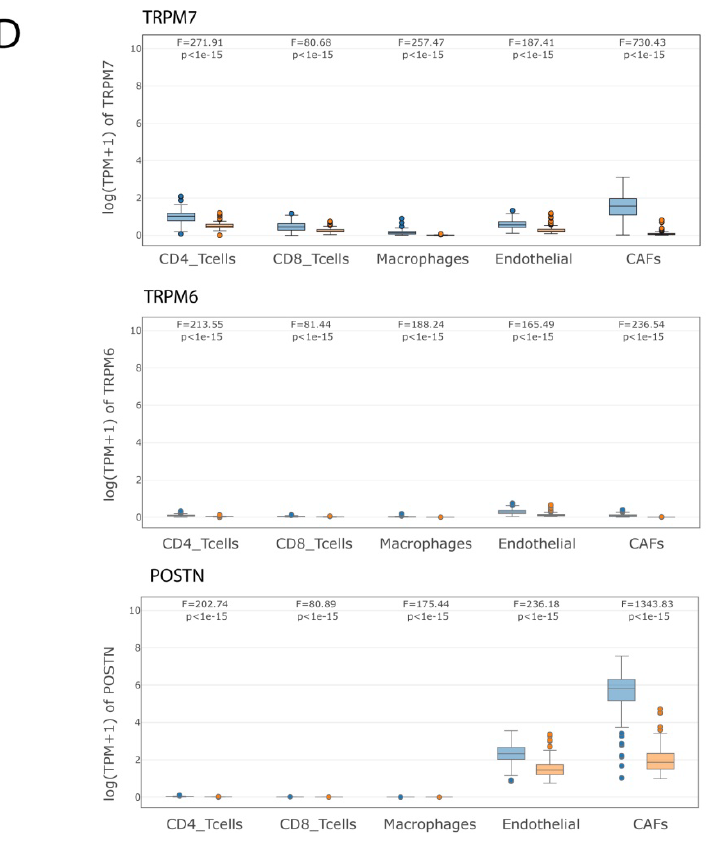
Figure 7. TRPM7 and POSTN expressions are increased in Cancer-Associated Fibroblasts (CAFs) in pancreatic cancer. ( A ) Relative mRNA levels of TRPM7, TRPM6 and POSTN in PDAC and a normal pancreas. Boxplots were generated with GEPIA from TCGA and GTEX datasets. Relative levels are expressed as log2 transcripts per million bases (TPM). * indicates p < 0.05 ( t − test). ( B ) Correlation analysis of TRPM7 and POSTN in PAAD TCGA dataset. ** indicates p < 0.01 ( t − test) ( C ) Correlation analysis of TRPM7 and POSTN in GSE28735 dataset. ** indicates p < 0.01 (paired t − test). ( D ) Relative mRNA levels of TRPM7, TRPM6 and POSTN in CD4+, CD8+, endothelial cells, macrophages and cancer associated fibroblasts (CAFs) from TCGA tumors and normal pancreas samples. EPIC deconvolution of the dataset was performed using GEPIA2021 tool. Quantitative comparisons of TRPM7, TRPM6 and POSTN expression were analyzed using ANOVA